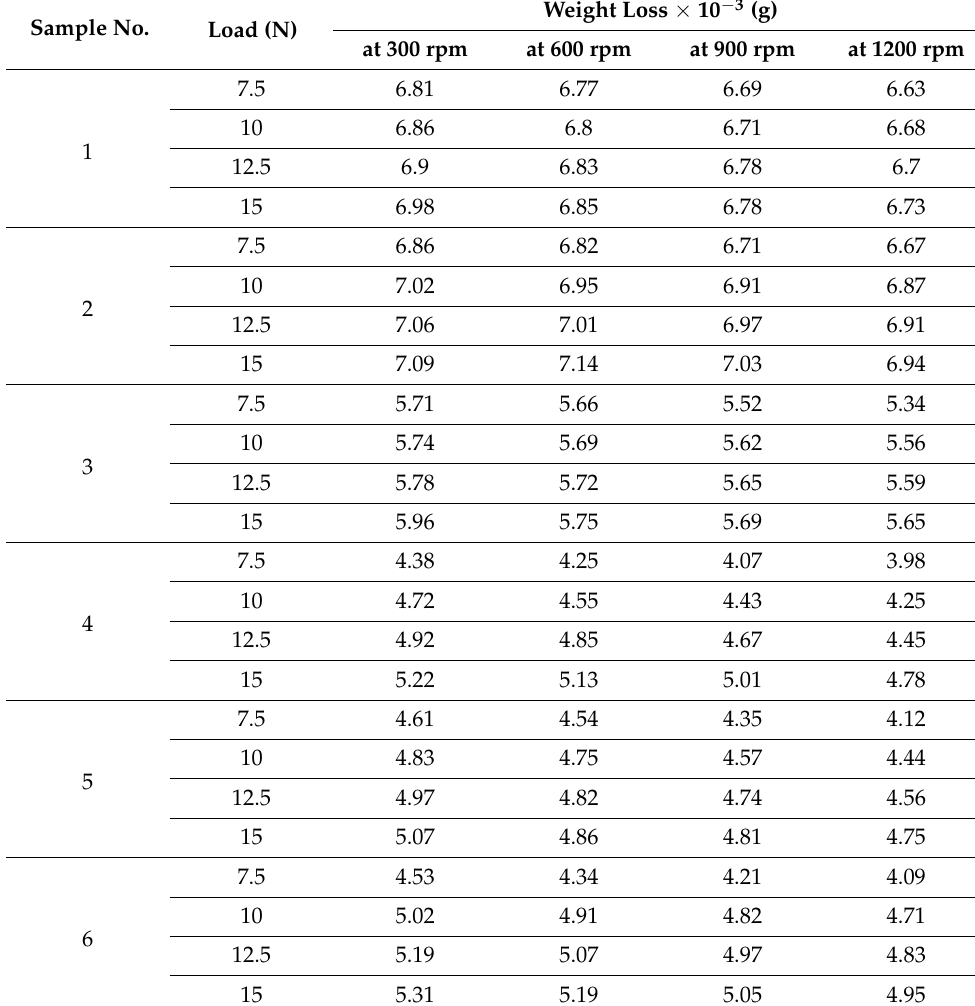
Table 5. Weight loss of each sample. Sample